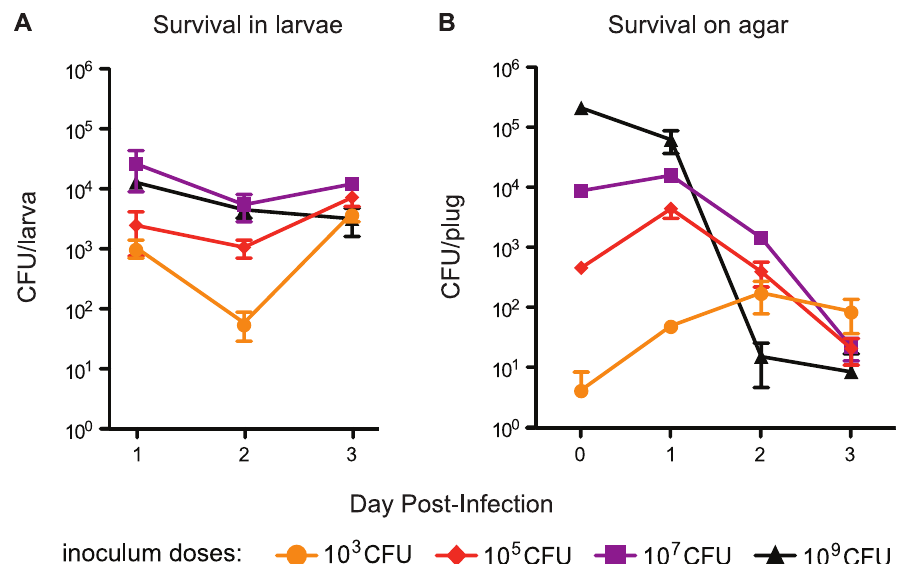
Fig 1. Y . pestis is able to colonize the midgut of D . melanogaster larvae. One day after hatching, larvae were infected with the indicated inoculum of Y . pestis KIM6+. Bacterial loads were evaluated in two ways at the indicated times post infection: (A) Means and standard error from five individual larvae at each time point that were surface-sterilized and homogenized; (B) Means and standard error from three agar samples that were taken at each time point and suspended in 150 μ l sterile PBS. The bacterial suspensions from both methods were serially diluted, plated on YSA, and incubated at room temperature for two days before counting to determine bacterial survival within larvae or on the agar plates. Data is representative of at least three independent trials.